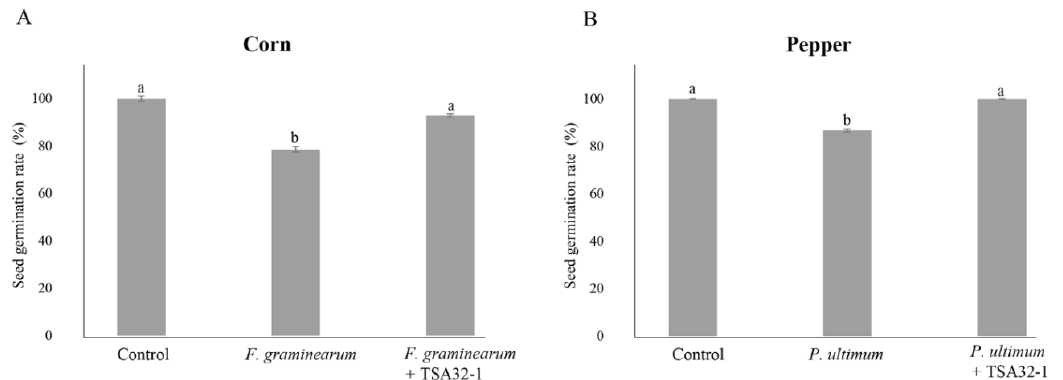
8 of 17 Figure 3. Antifungal activity of test strains against the indicator strains. Inhibition effect of mycelial growth of Fusarium fujikuroi KACC 44002 ( A ), F. graminearum KACC 41040 ( B ), F. graminearum KACC 46434 ( C ), F. graminearum KACC 41044 ( D ), F. oxysporum KACC 41088 ( E ), F. oxysporum f. sp . Raicis-lycopersici O1090 ( F ), Botryosphaeria dothidea KACC 45481 ( G ), Botrytis cinerea KACC 47009 ( H ), Alternaria alternata KACC 45440 ( I ), Diaporthe actinidiae SN18 ( J ), Glomerella cingulate 06-KN-1 ( K ), Colletotrichum nymphaea GNC1 ( L ), Colletotrichum acutatum KACC 40042 ( M ), Cylindrocarpon destructans KACC 41077 ( N ), Pythium ultimum KACC40705 ( O ), and Rhizoctonia solani AG-1 KACC 40101 ( P ) by B. velezensis TSA32-1. 3.2.3. Plant Protection Effects of Seed Treatments with TSA32-1 The germination rate of seeds infected with the phytopathogenic fungus F. graminearum KACC41044 on corn seeds was 78.6%, and seeds coated with TSA32-1 showed a germination rate of 92.9% even after pathogen infection (Figure 4A). When the seeds were treated with TSA32-1, the germination rate was higher than that of corn seeds